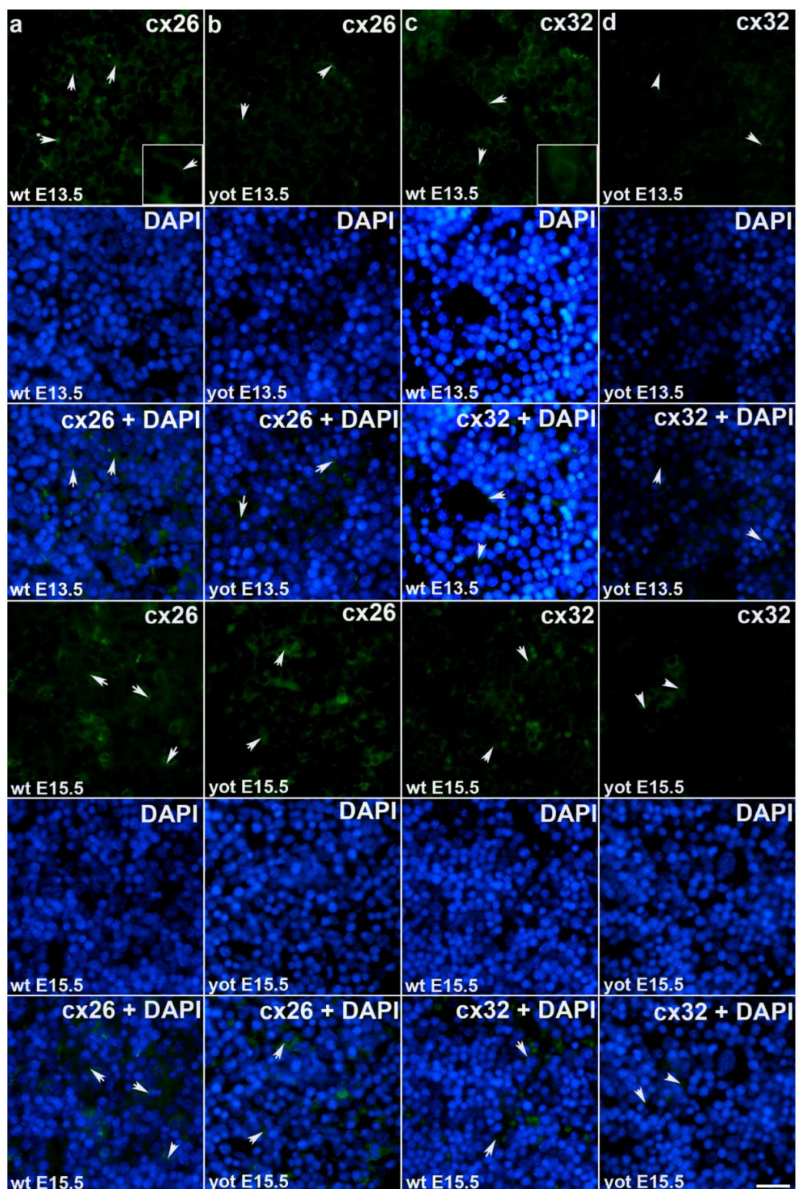
Figure 2. Immunofluorescence staining of connexins (Cxs): Cx26 and Cx32 in wild type and yotari mouse liver at gestation days E13.5 and E15.5. Immunoexpression of Cx26, 4 (cid:48) ,6-diamidino-2- phenylindole dihydrochloride (DAPI) staining and merged Cx26 and DAPI at E13.5 and E15.5 in wild type ( a ) and yotari ( b ). Immunoexpression of Cx32, DAPI staining and merged Cx32 and DAPI at E13.5 and E15.5 in wild type ( c ) and yotari ( d ). * Autofluorescence of erythrocytes not to be mistaken with positive immunofluorescence staining of connexins. The scale bar is 8 µ m, refers to all